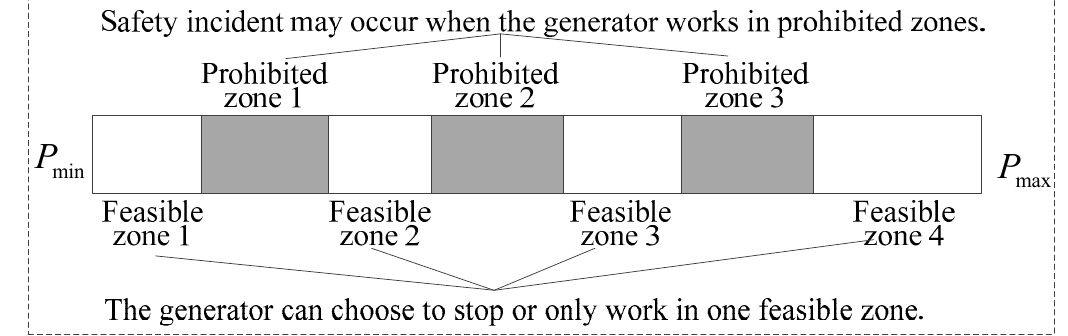
Figure 3. Sketch map of the gas-fired generator with disjoint-prohibited operating zones.